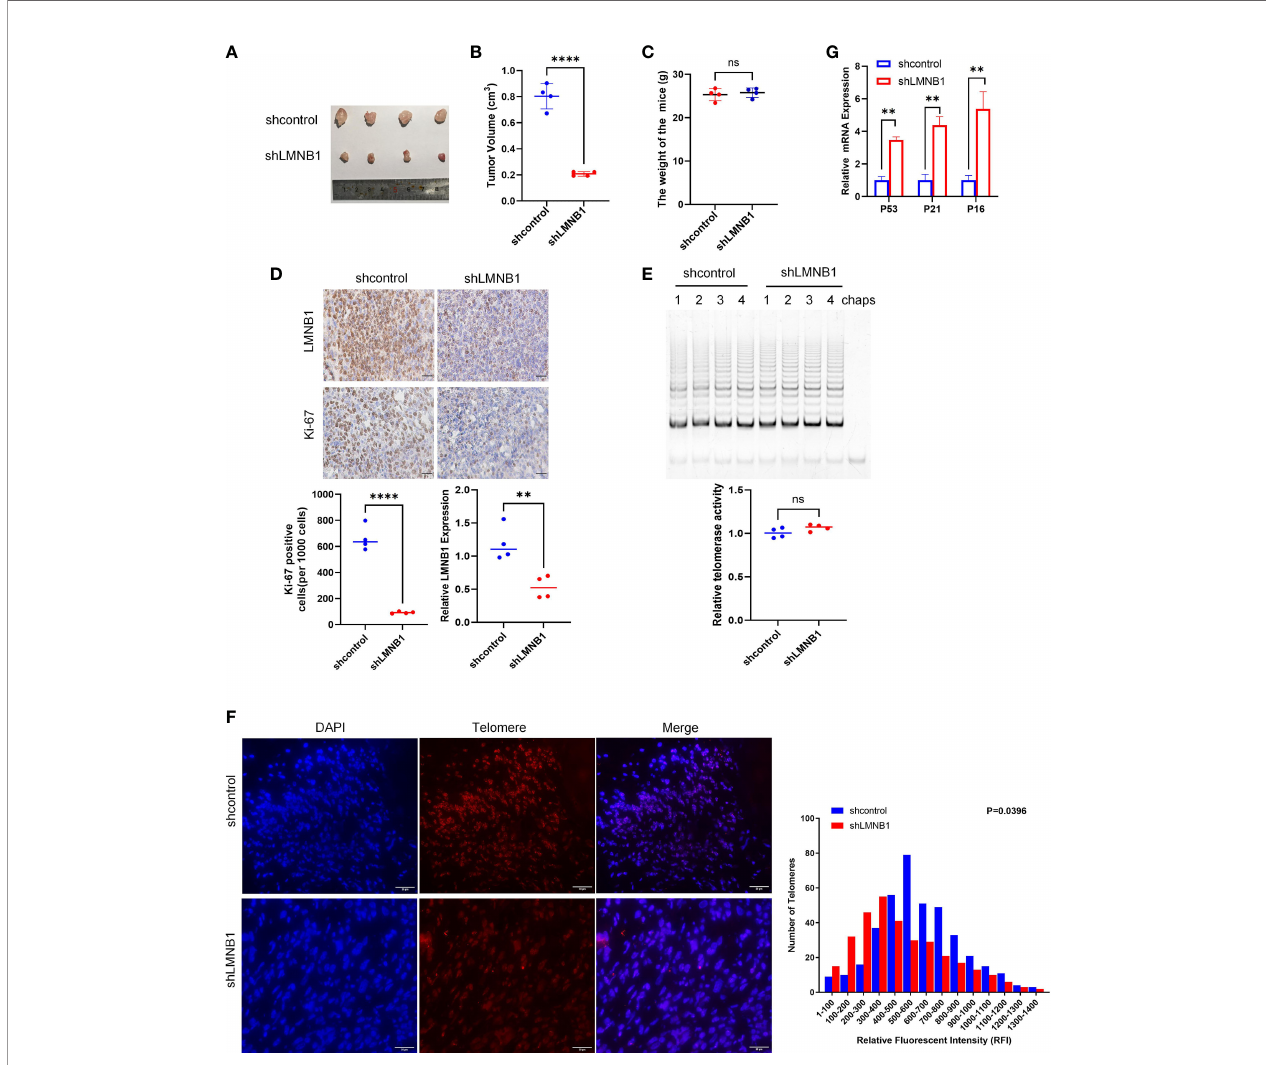
FIGURE 6 | LMNB1 knockdown inhibits tumor growth in A549 xenograft models. (A – C) A549 cells stably expressing shcontrol or shLMNB1 were injected subcutaneously in nude mice (n = 4 for each group). Tumor value and mice bodyweight were measured 1 month later. (D) The expression of LMNB1 and Ki-67 in tumors of two groups were detected by immunohistochemistry. Scale bar, 30 m m. (E) Telomerase activity in tumors of each mice was detected by TRAP. (F) Telomere length was evaluated in paraf fi n embedded sections of tumor tissue using Q-FISH. The Image J software was used to analyze the telomere length of tumor sections, as indicated by fl uorescence intensity. Scale bar, 50 m m. (G) The expression of P53, P21 and P16 mRNA in tumors were detected by RT-qPCR. **p<0.01, ****p<0.0001, ns means no signi fi